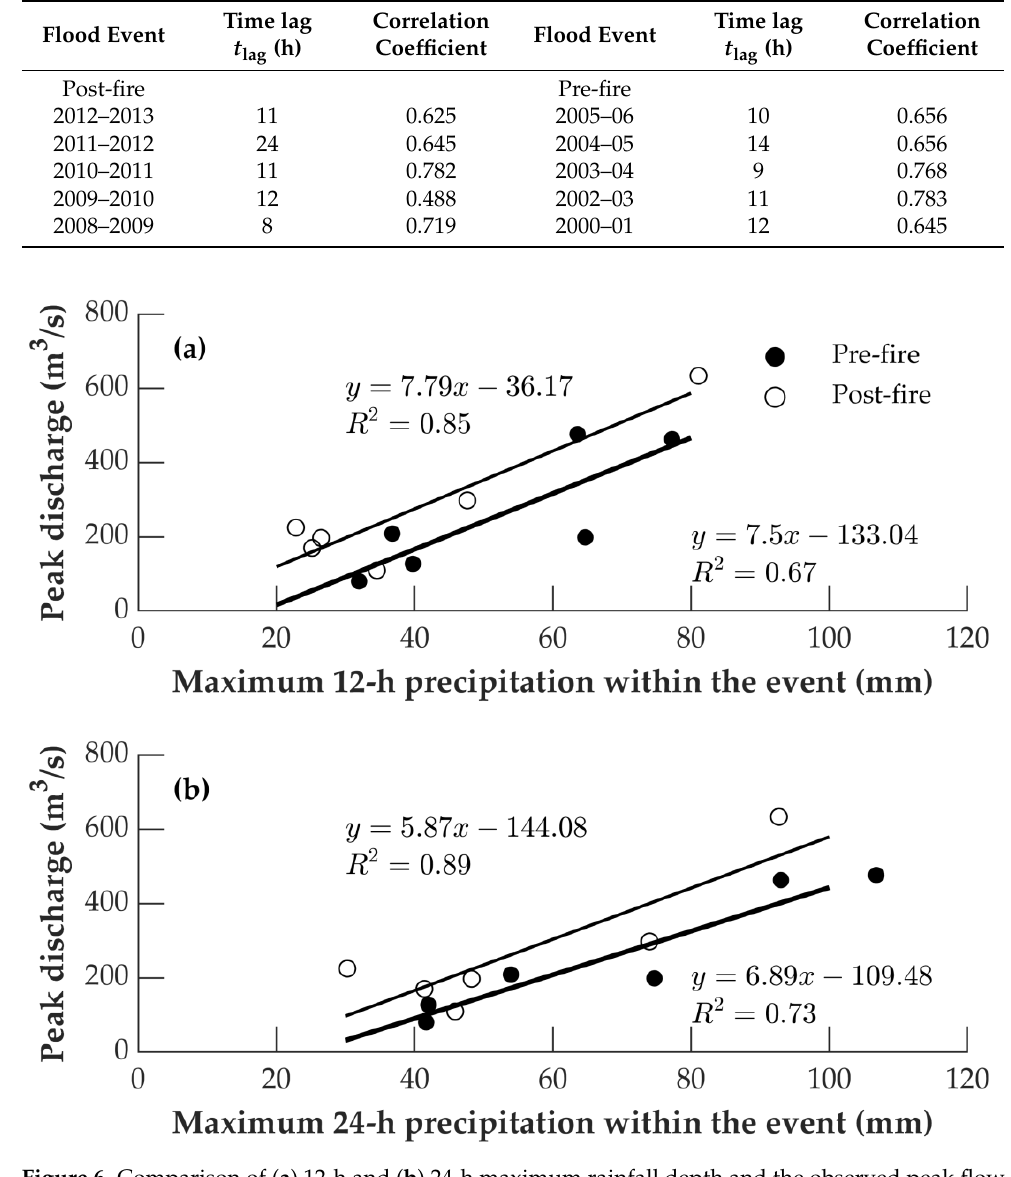
Table 5. Comparison of time lag, t lag , for pre- and post-fire flood events.